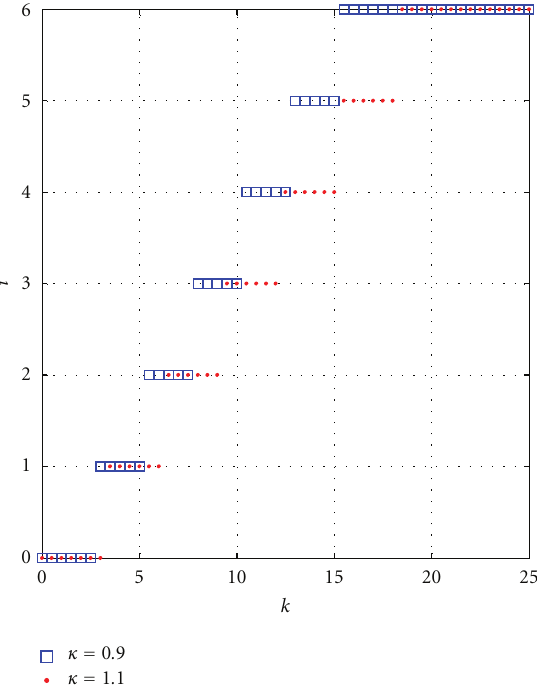
Figure 6: Commutation between